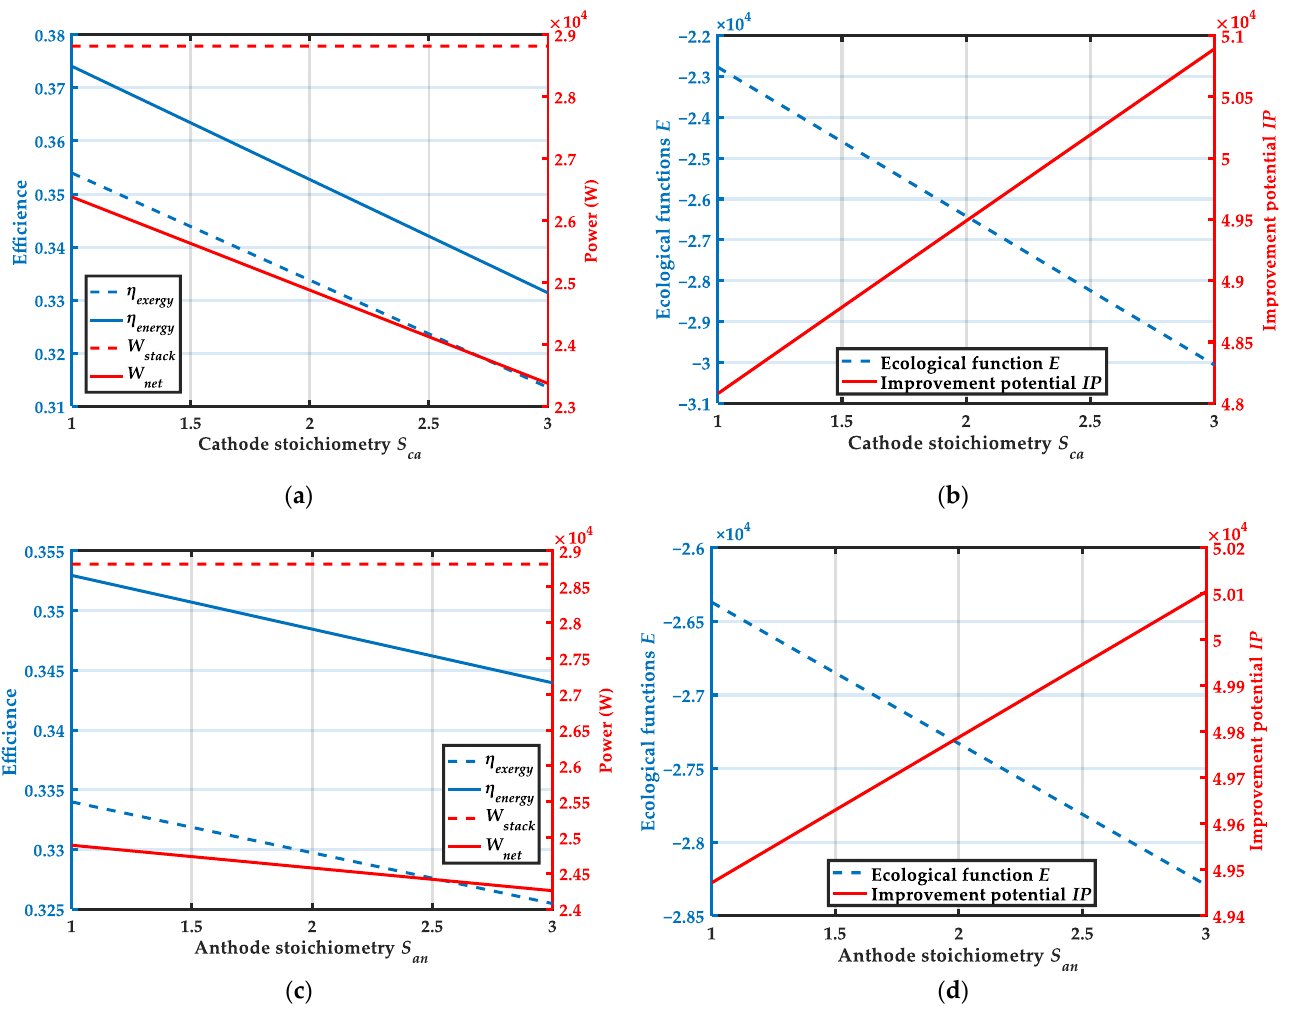
Figure 8. Variation trends of system performance with cathode and anode stoichiometry: ( a ) Variation trends of 𝜂 𝑒𝑛𝑒𝑟𝑔𝑦 , 𝜂 𝑒𝑥𝑒𝑟𝑔𝑦 , 𝑊 𝑠𝑡𝑎𝑐𝑘 and 𝑊 𝑛𝑒𝑡 with cathode stoichiometry 𝑆 𝑐𝑎 ( b ) Variation trends of ecological function 𝐸 and improvement potential 𝐼𝑃 with cathode stoichiometry 𝑆 𝑐𝑎 . ( c ) Variation trends of 𝜂 𝑒𝑛𝑒𝑟𝑔𝑦 , 𝜂 𝑒𝑥𝑒𝑟𝑔𝑦 , 𝑊 𝑠𝑡𝑎𝑐𝑘 and 𝑊 𝑛𝑒𝑡 with anode stoichiometry 𝑆 𝑎𝑛 ; ( d ) Variation trends of ecological function 𝐸 and improvement potential 𝐼𝑃 with anode stoichiometry 𝑆 𝑎𝑛 .